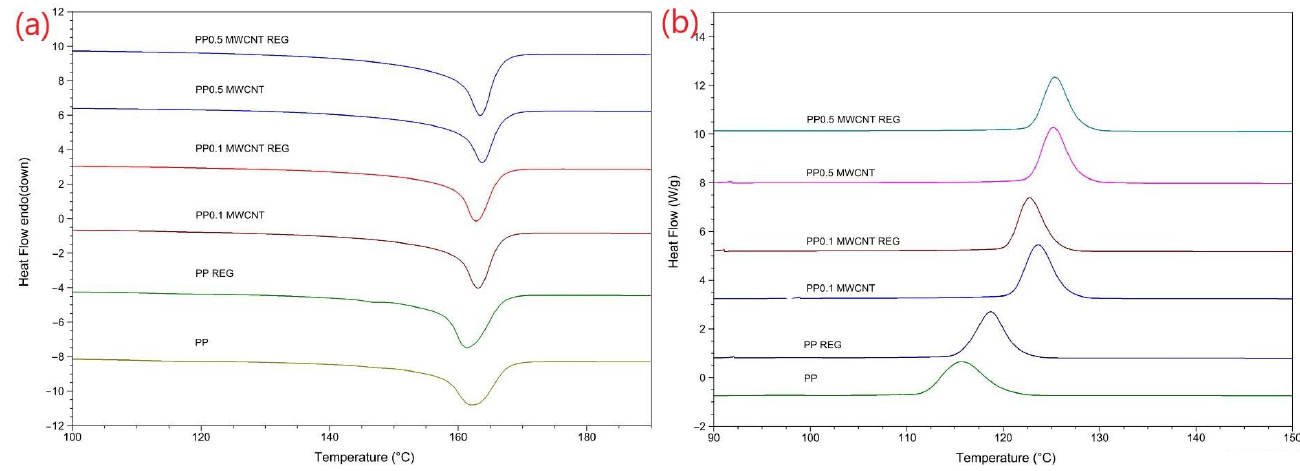
Figure 3. DSC curves of melting endotherms ( a ) and exoterms ( b ) of PP/MWCNT nanocomposites.